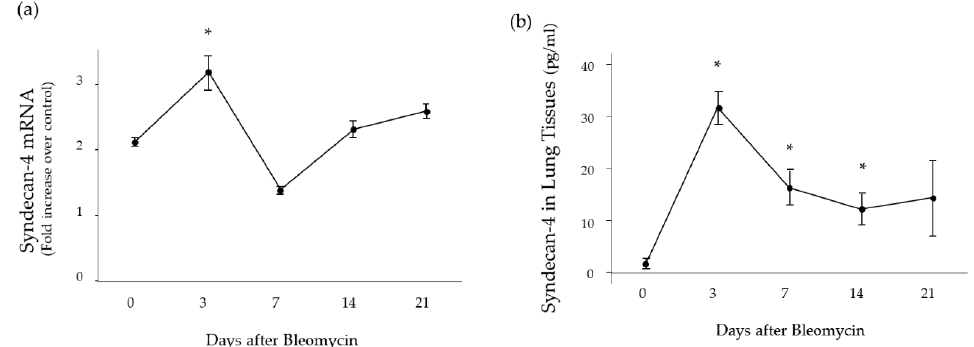
Figure 1. The expression of syndecan-4 in mouse lung tissue after intratracheal bleomycin instillation. ( a ) mRNA expression of syndecan-4 in the lung tissue of mice was significantly elevated at 3 days compared to baseline. ( b ) Syndecan-4 protein concentration in the lung tissue of mice was significantly elevated at 3, 7 and 14 days compared to baseline. The statistical di ff erences between each group and Day 0 were compared using the Mann-Whitney U test. *, p < 0.05 vs. Day 0 ( n = 3–6 / each